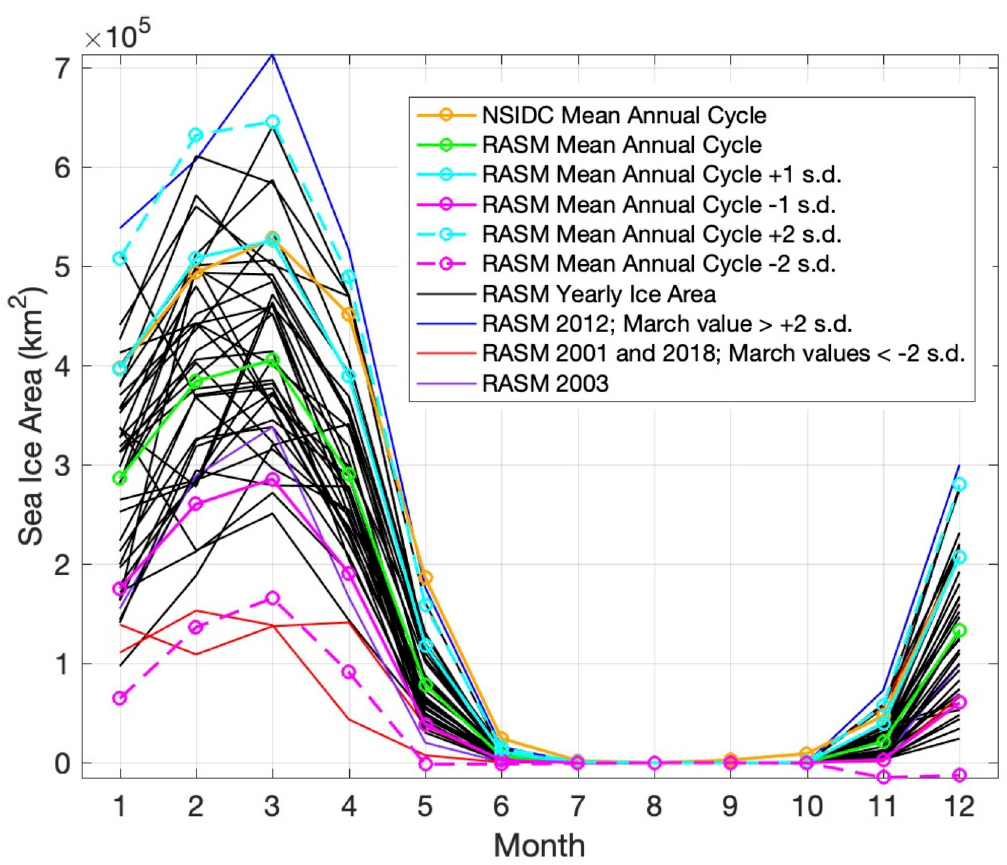
Fig 8. Annual cycle of sea ice area in the Bering Sea. Annual cycle of sea ice area in the Bering Sea (km 2 ) from the National Snow and Ice Data Center (NSIDC; orange) satellite product [37] (long-term mean based on the years 1980–2018), from RASM (long-term mean based on the years 1980–2018; green), and yearly annual cycles from RASM (black). Cyan and magenta lines indicate +/- 1 (solid) and 2 (dashed) standard deviations. The year 2012 (blue) and years 2001 and 2018 (red) have March values outside 2 standard deviations from the mean. The year 2003 is shown in